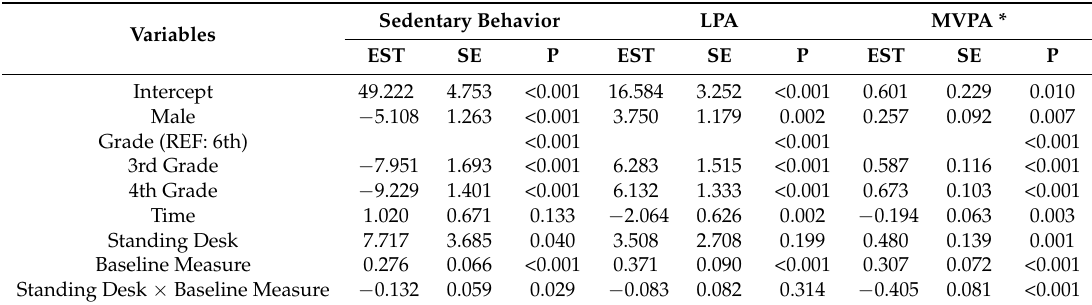
Table 3. Mixed effects models to predict sedentary behavior and physical activity during classroom time at follow-up based on desk allocation and baseline levels.